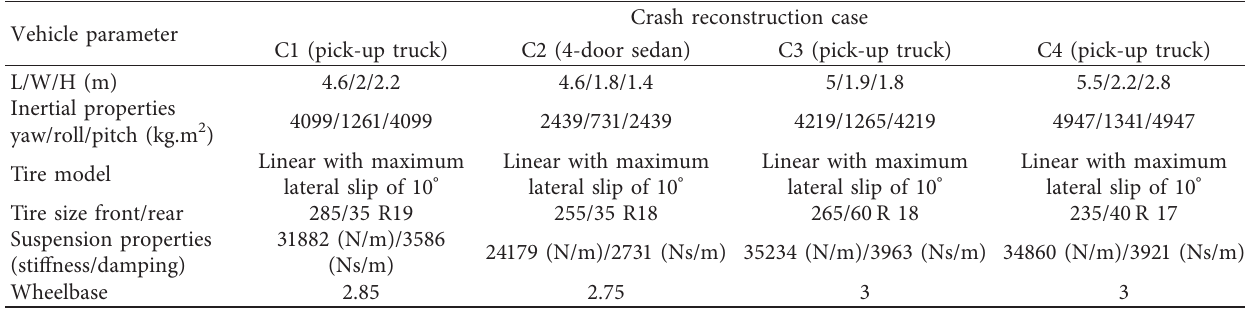
Table 9: Summary of SV vehicle parameters that were used in accident reconstruction ∗